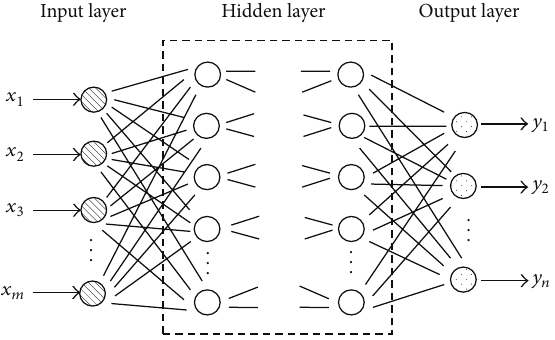
Figure 3: Typical structure of a BP neural network.